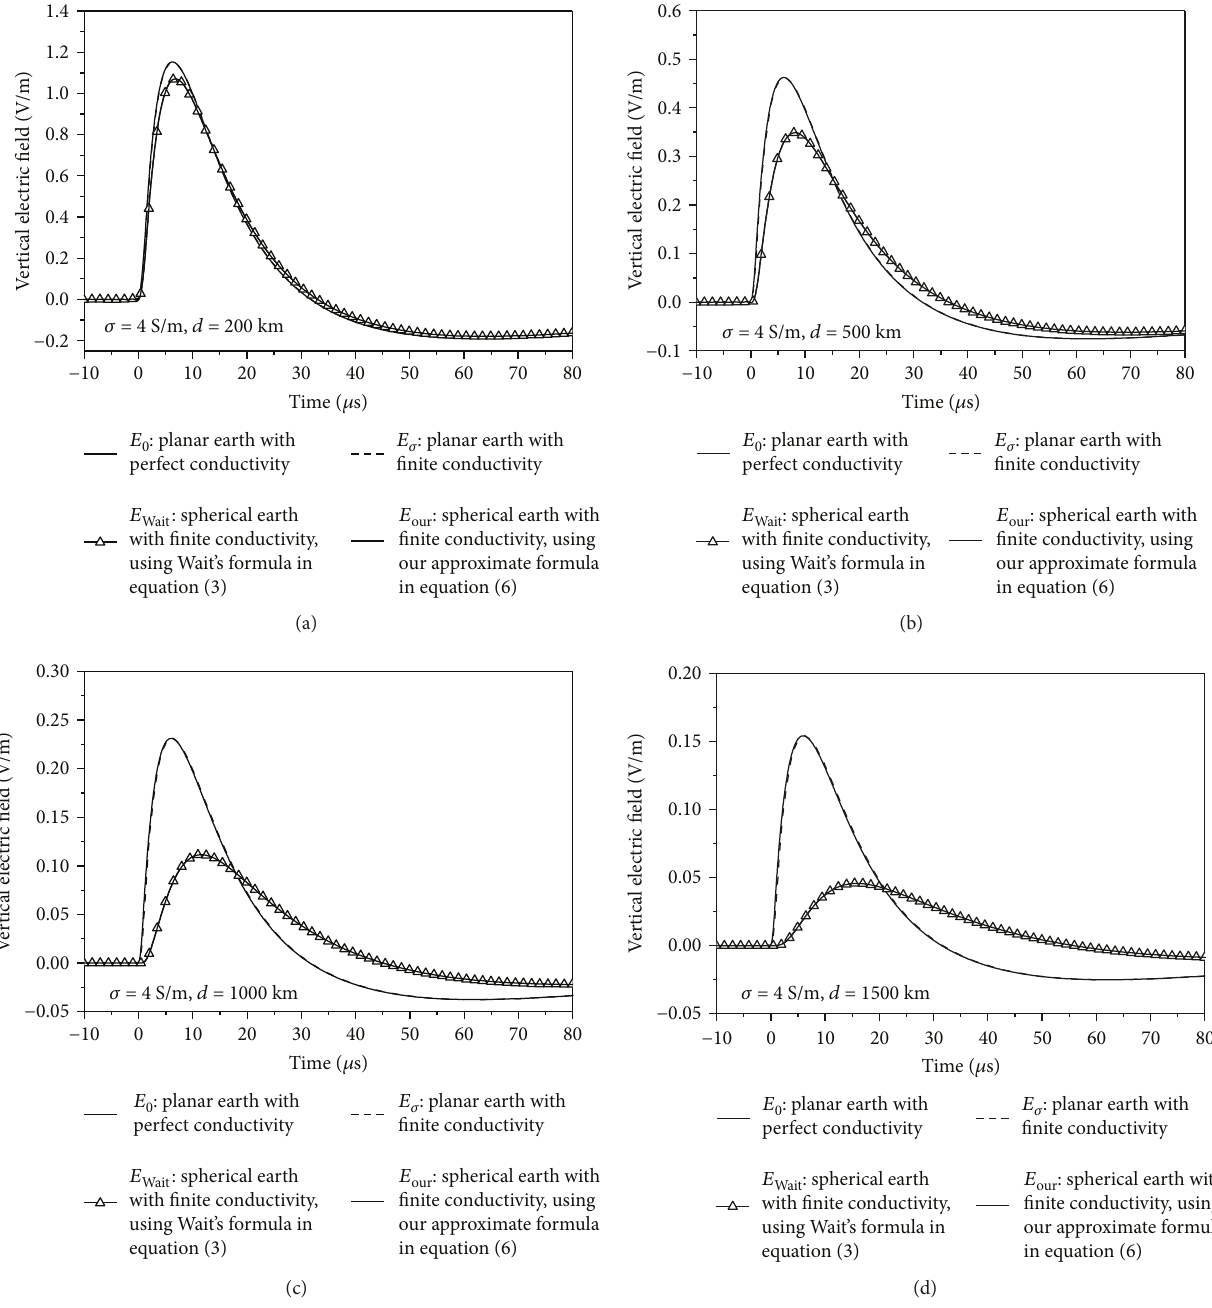
Figure 3: Comparison of the vertical electric fi eld calculated by our approximate formula in (6) and Wait ’ s original formula in (3) for the ocean propagation path considering the earth curvature at di ff erent distances of (a) 200 km, (b) 500km, (c) 1000km, and (d) 1500 km. Wait ’ s original formula is solved by the Newton – Raphson root- fi nding method. The polarity of a vertical electric fi eld pointing downward is de fi ned to be